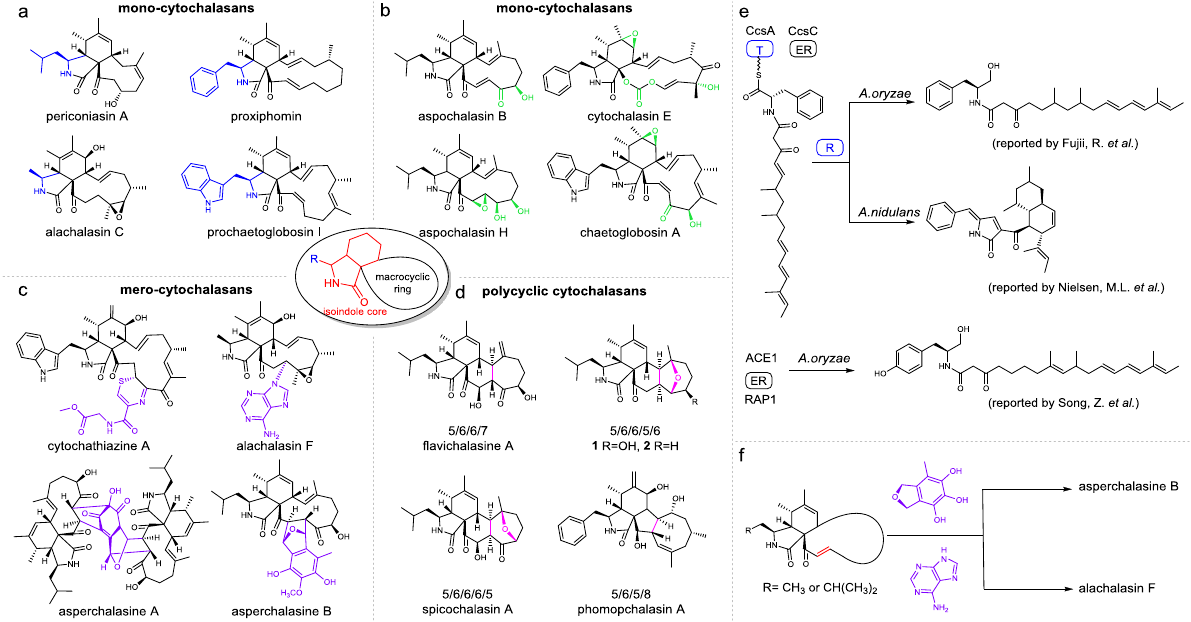
Fig. 1 Structural and chemical diversity of the cytochalasin family compounds. a – d Representative mono-, mero- and polycyclic cytochalasans reveal four variable bioconversion processes. e Previously unsuccessful examples of the reconstitution of aromatic ammino acid-type cyt BGCs in heterologous hosts. f Conversion of moCYTs to both meCYTs and pcCYTs via a proposed ole fi n intermediate in aliphatic amino acid-type CYT